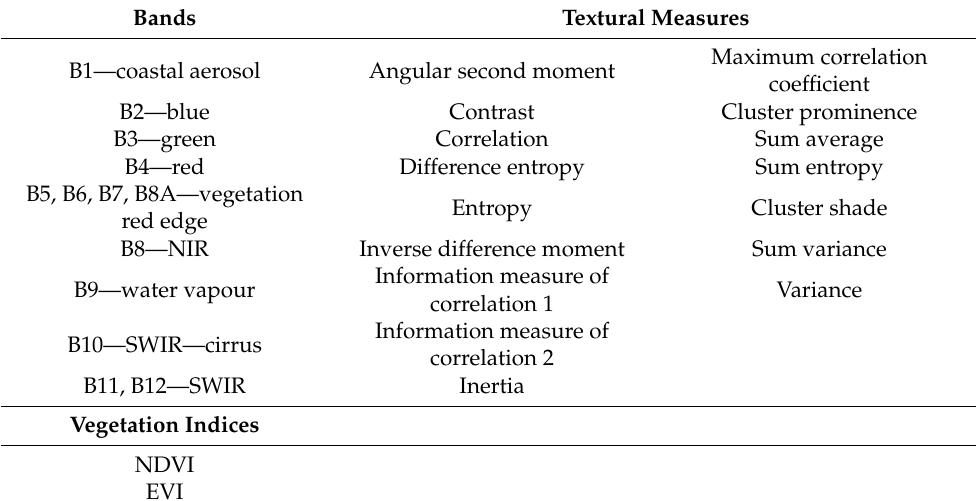
Table 2. Features (bands, indices, and textural measures) used as inputs to the classifications gener- ated from a composite of individual Sentinel-2 images taken from 30 June 2019 to 30 June 2020. Bands Textural Measures Maximum correlation B1—coastal aerosol Angular second moment coefficient B2—blue Contrast Cluster prominence Correlation Sum average